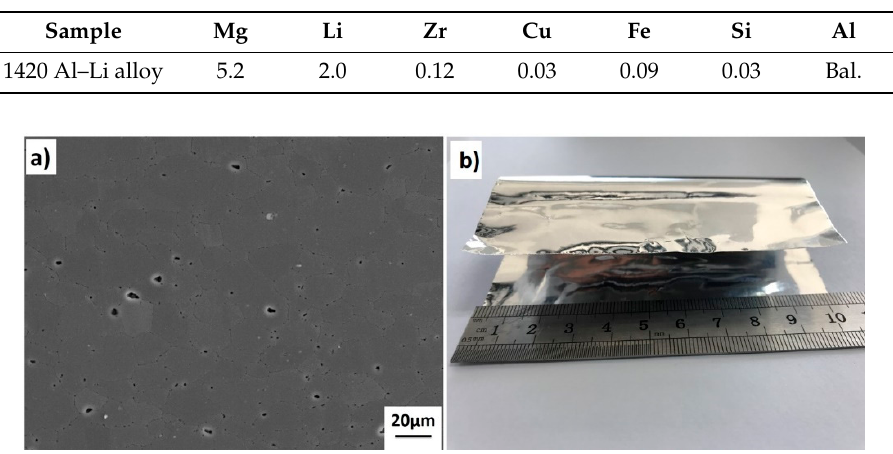
Table 1. Chemical composition of the as-received 1420 Al–Li plates (wt %).